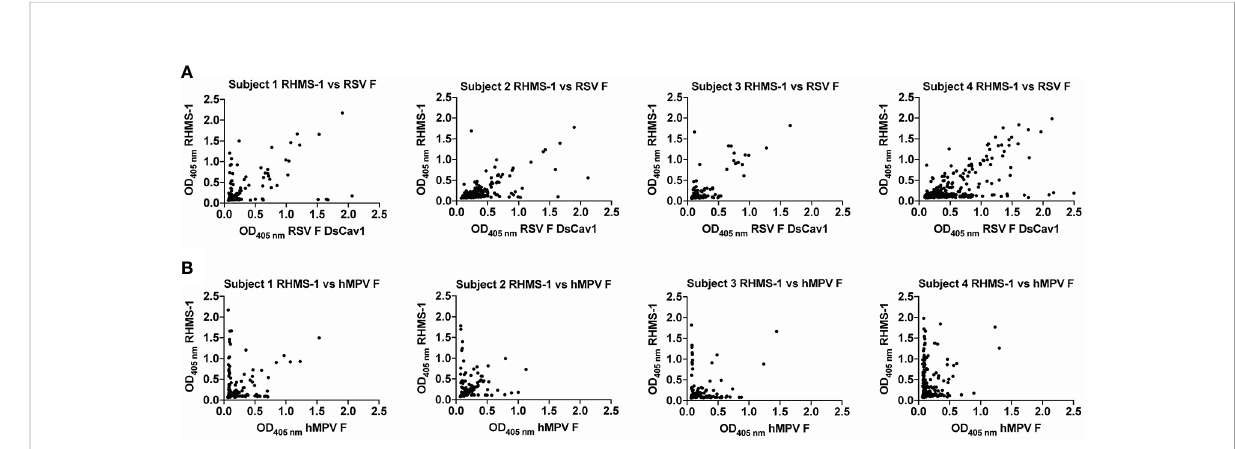
FIGURE 5 Human PBMCs binding to F proteins. ELISA OD 405 nm values of B cell culture supernatants binding to RHMS-1 vs. RSV A2 F DsCav1 (A) and RHMS-1 vs. trypsinized hMPV B2 F monomer (B) . Each dot represents the B cell supernatant in a single well of a 384 well plate initially containing 20,000 PBMCs. Figures were generated by GraphPad Prism.